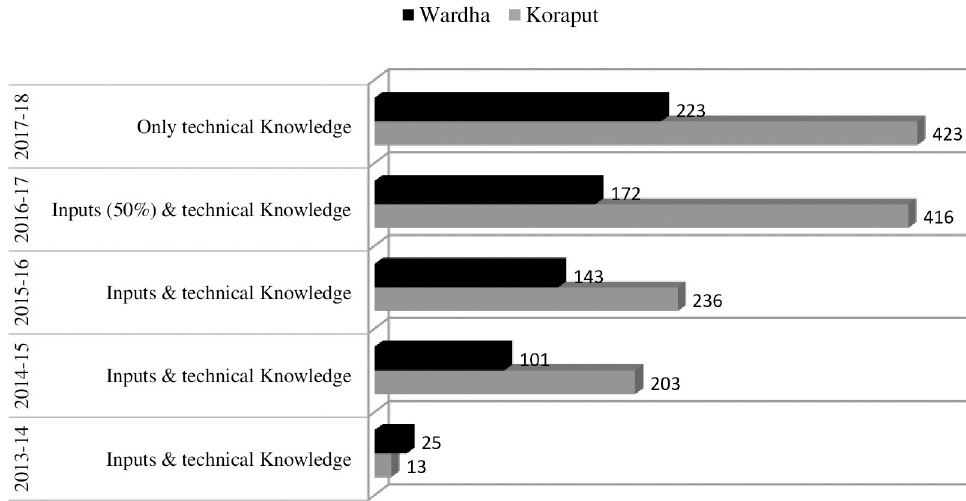
Fig 2. No. of farmers participating in FSN interventions (total households Koraput = 658, Wardha = 556).